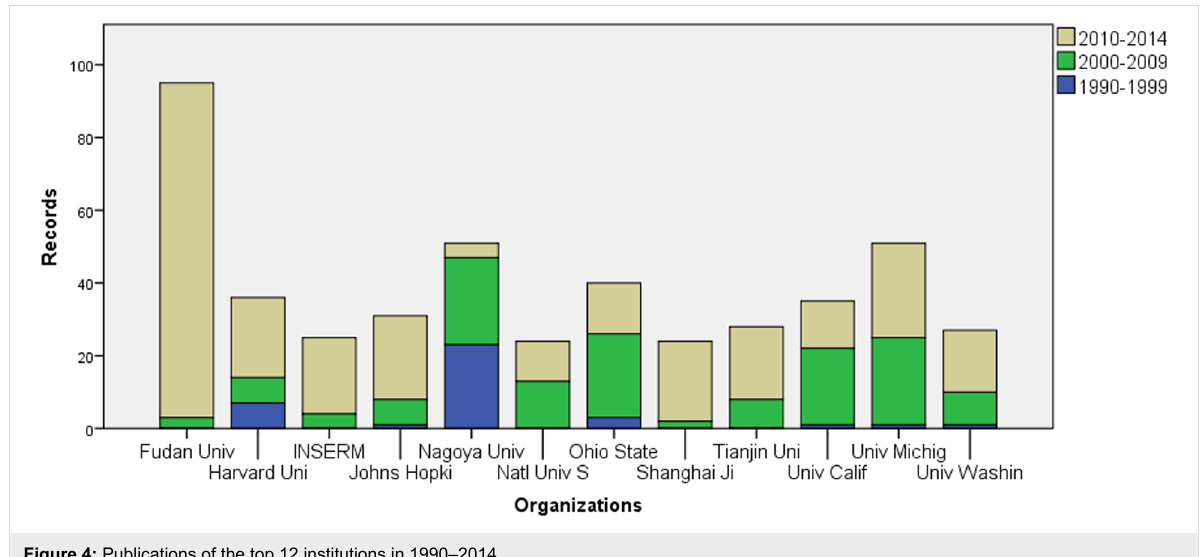
Figure 4: Publications of the top 12 institutions in 1990–2014.